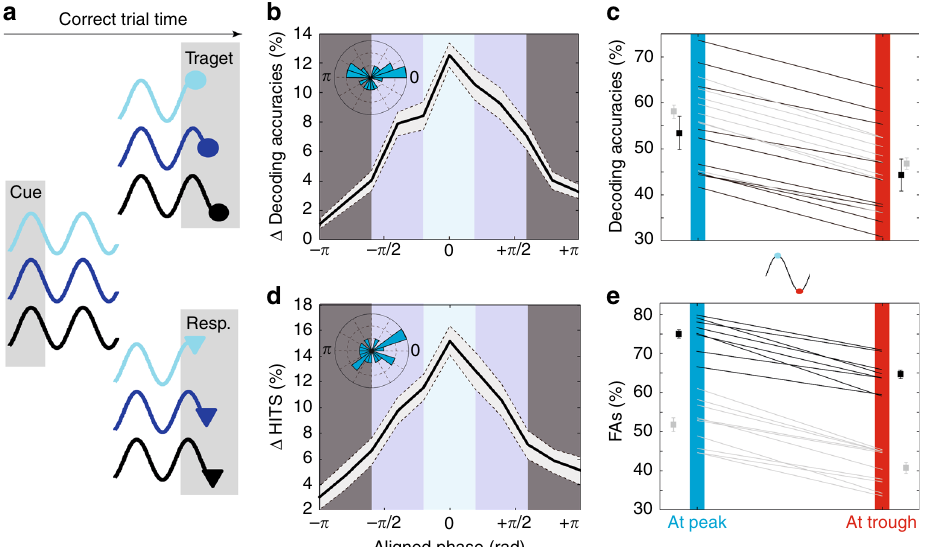
Fig. 4 PFC target-related information and hit rates depend on when the TARGET is presented relative to attentional oscillation cycles. a Categorization schema of trials as a function of when the target (top) and the behavioral response (bottom) were presented relative to attentional oscillation cycles. b Target related information as a function of phase with respect to the attentional oscillation cycles. Zero phase corresponds to optimal phase and not to zero phase-locking relative to the attentional signal, hence the observed phase shift distribution (inset: radial distribution of phase shifts relative to cue presentation, 18 sessions). c Peak (upper third of the distribution in ( b )) to trough (lower third of the distribution in ( b ) variations (±s.e.) in target-related information, for each monkey (M1: black, M2: gray), for each session. d Percentage of hits is signi fi cantly higher in trials presented at optimal phase with respect to the attentional oscillation cycles (inset: radial distribution of phase shifts relative to cue presentation, 18 sessions). e Peak to trough variations in percentage of hits (±s.e.), for each monkey (M1: black, M2: gray), for each